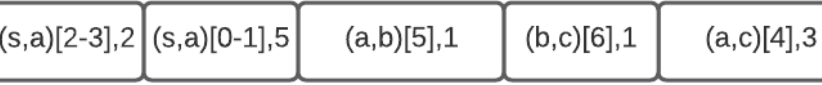
Figure 12. Interval list in non-decreasing order of